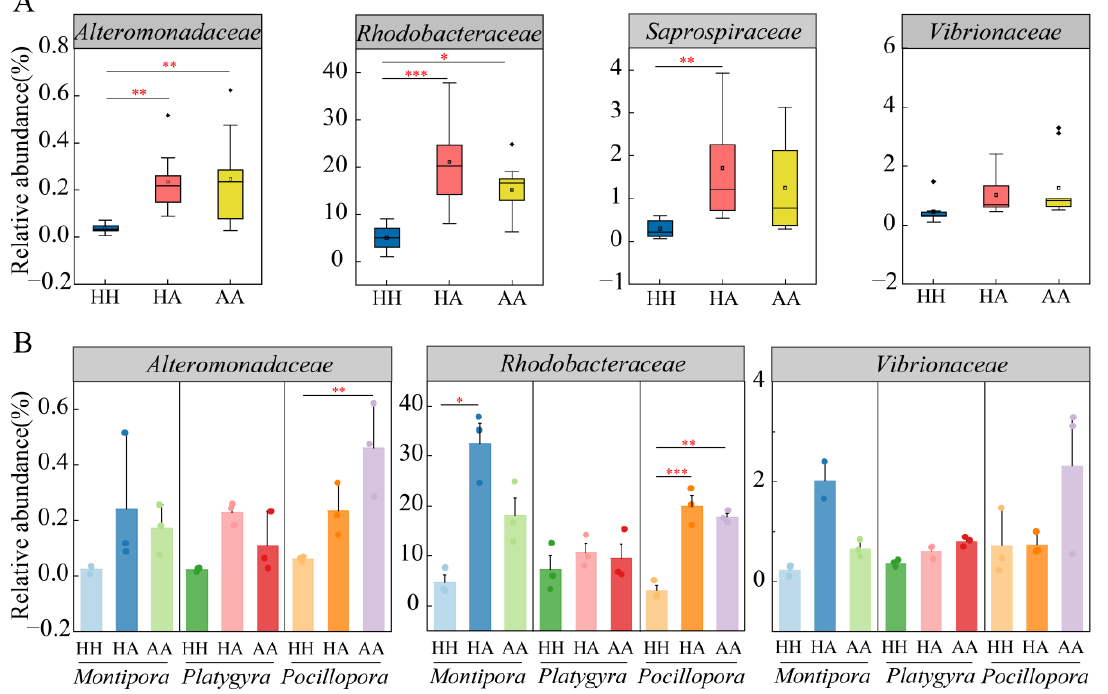
Figure 4. Significant differences in the relative abundance of bacterial categories at the family level: ( A ) Differences between groups; ( B ) Differences between coral genera. p < 0.05, p < 0.01, and p < 0.001 are marked with “*”, “**”, and “***”, respectiv ely.